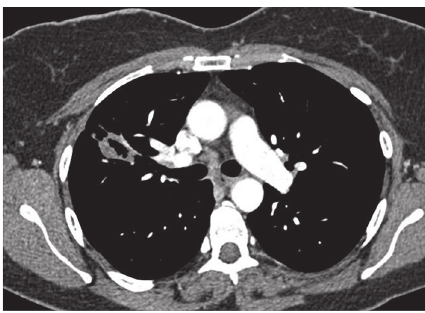
Figure 2: CT thorax axial view showing the cavitary lesion in the right upper lobe of the lung.